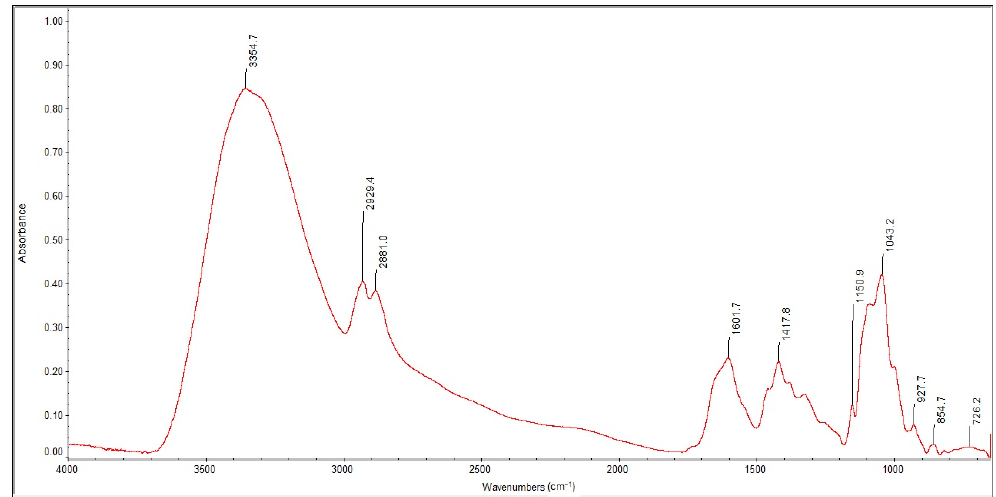
Figure 7. Fourier Transform Infrared Study (FTIR) spectra of the lyophilized foam before irradiation sterilization.